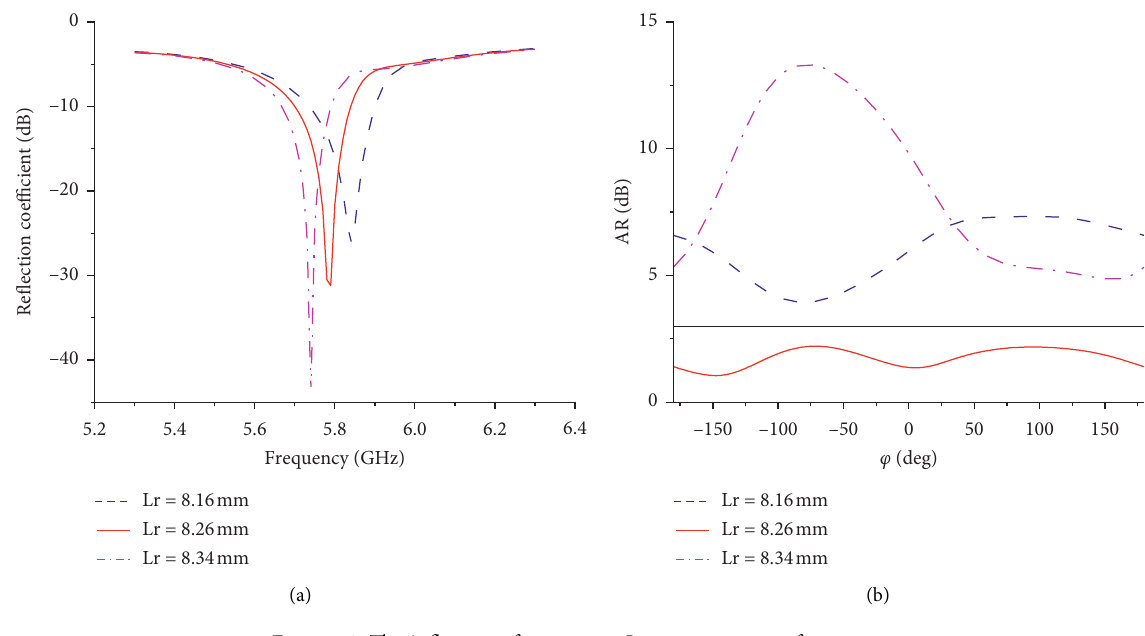
Figure 4: The influence of parameter Lr on antenna